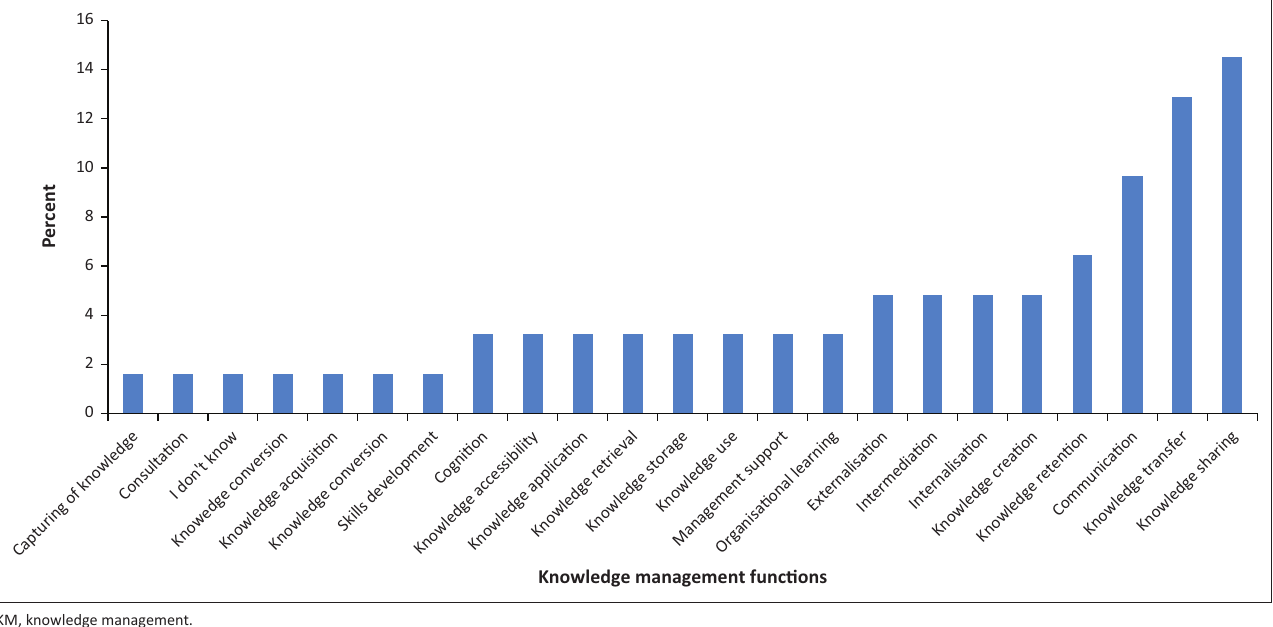
FIGURE 7: Knowledge management functions applicable during a period of